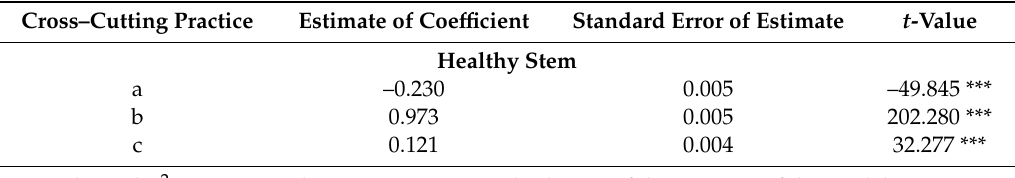
Table 6. Regression models for the sawlog removal by cross-cutting